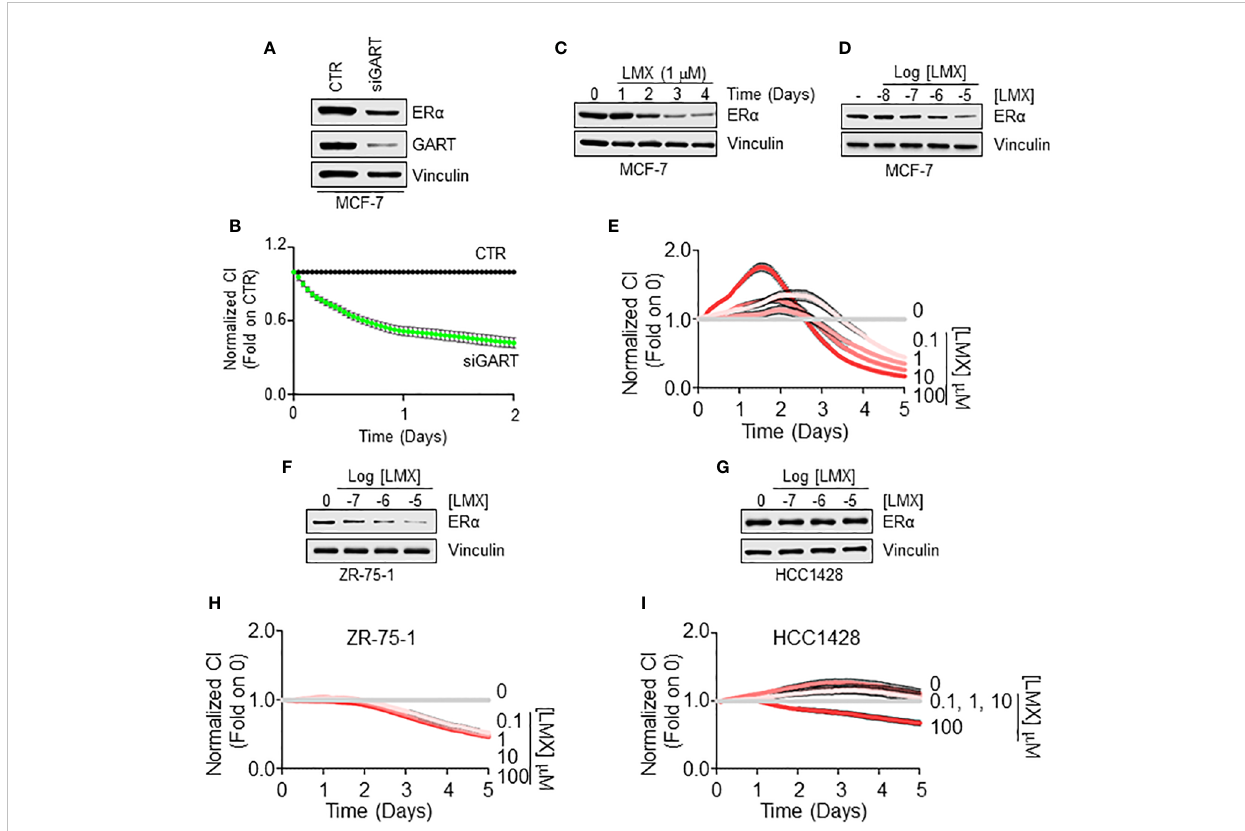
FIGURE 4 GART-dependent control of ER a stability and cell proliferation in Not-IDC and IDC breast cancer cells. Western blot analyses of ER a expression levels in MCF-7 cells treated with GART siRNA oligonucleotides for 24 hours (A) and with both the indicated time points (C) and the indicated doses (D) of lometrexol (LMX) doses for 48 hours. Blots are representative images of 4 independent experiments. Densitometric and statistical analyses are reported in Supplementary Figure 1. Growth curve analyses in MCF-7 cells were performed as indicated in the material and method section for 3 days in cells treated with GART siRNA oligonucleotides (B) and for 5 days in cells treated with the indicated doses of lometrexol (LMX) (E) . The graphs show the normalized cell index ( i.e. , cell number), which is detected with the xCelligence DP device and calculated at each time point with respect to the control sample. Each sample was measured in quadruplicate. For details, please see the material and methods section. Western blot analyses of ER a expression levels in ZR-75-1 (F) and HCC1428 (G) cells treated at the indicated doses of lometrexol (LMX) doses for 48 hours.